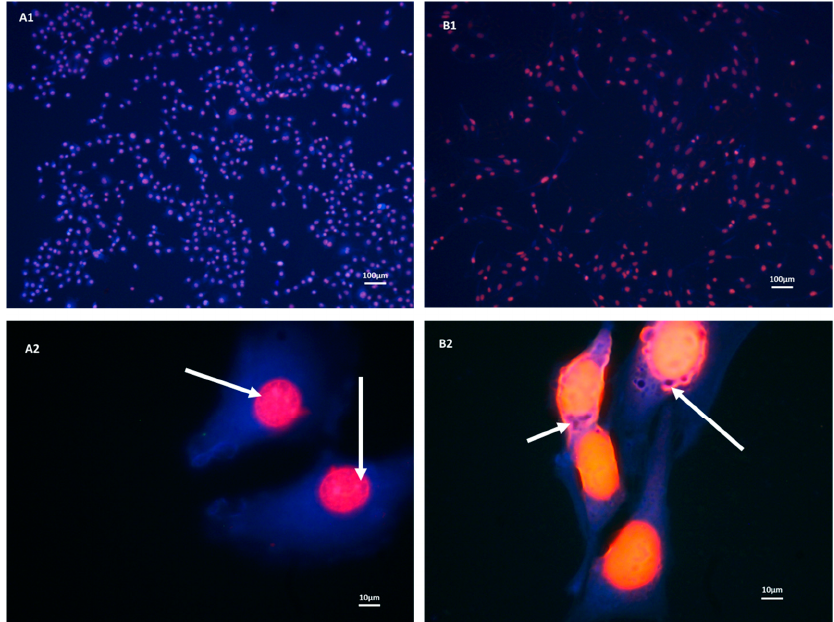
Figure 1. Micrographs show fluorescent images of b.End5 ( A1 ) and ( A2 ) and bEnd.3 cells ( B1 ) and ( B2 ) in normal culture. Both cells showed blue monochlorobimane solution (mBCl) fluorescence (due to binding with reduced glutathione (GSH)) in their cytoplasm, though at the higher magnification b.End5 appeared more deeply stained. Furthermore, plate A2 revealed a lower nucleo-cytoplasmic ratio in b.End5 cells suggesting more cytoplasmic GSH content than in bEnd.3 cells. Furthermore, multiple segments and rings of blue fluorescence (white arrows) were indicative of glutathione observed within the nuclei and nucleo-cytoplasmic interface in the cells of both cell types (Plates A2 and